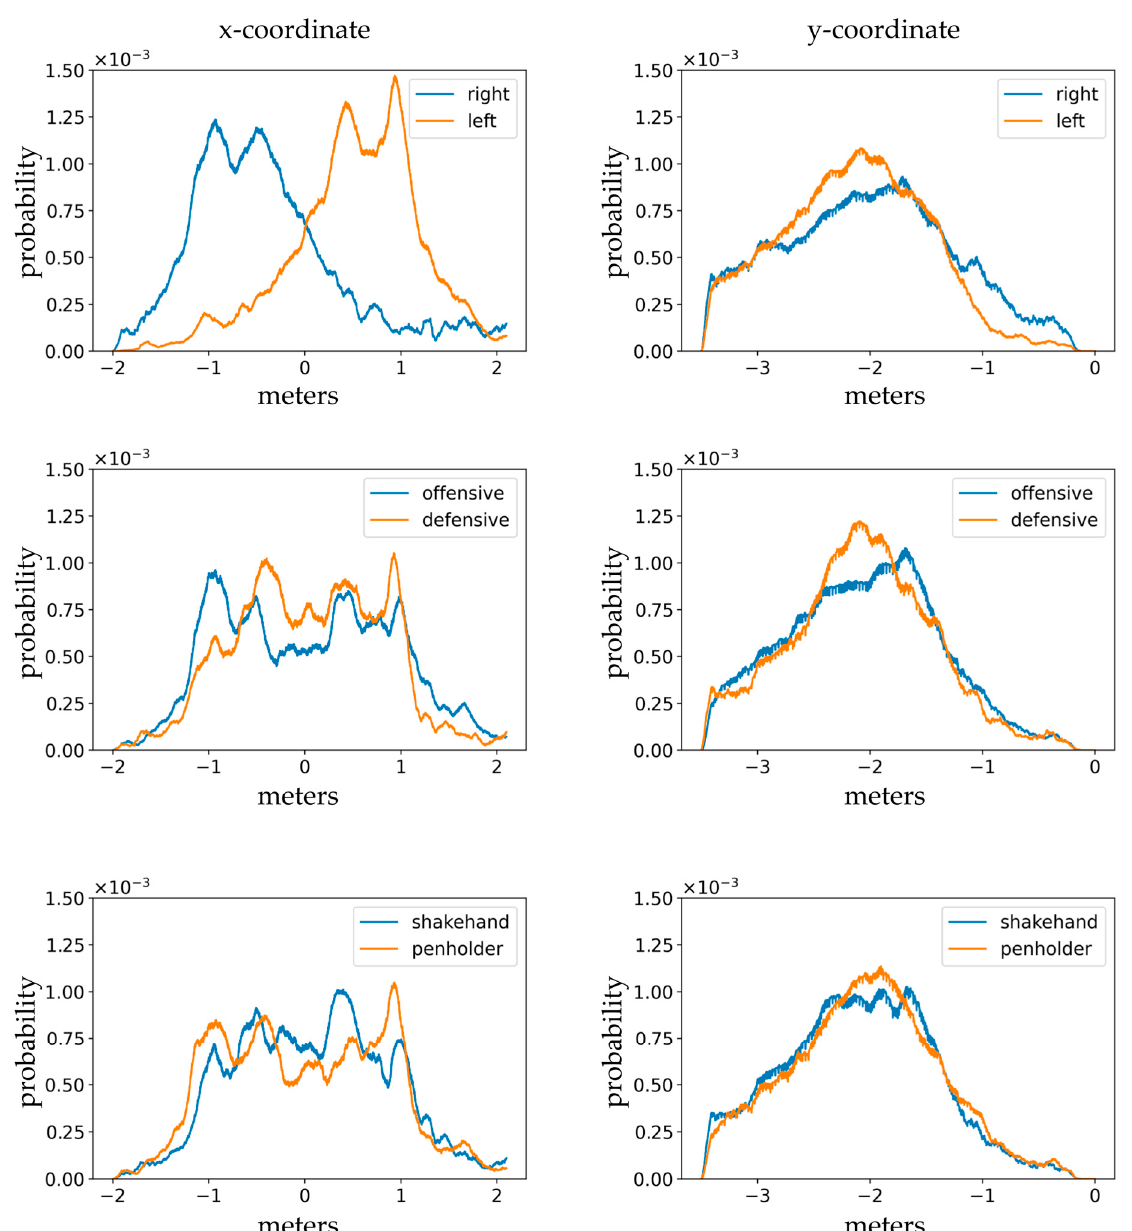
Figure 4. The probability rate of player positions on the x and y coordinates differentiated by right-handed vs. left-handed, offensive vs. defensive and shakehand vs. penholder grip players. Kolmogorov–Smirnov test analysis for the projected x and y distributions.